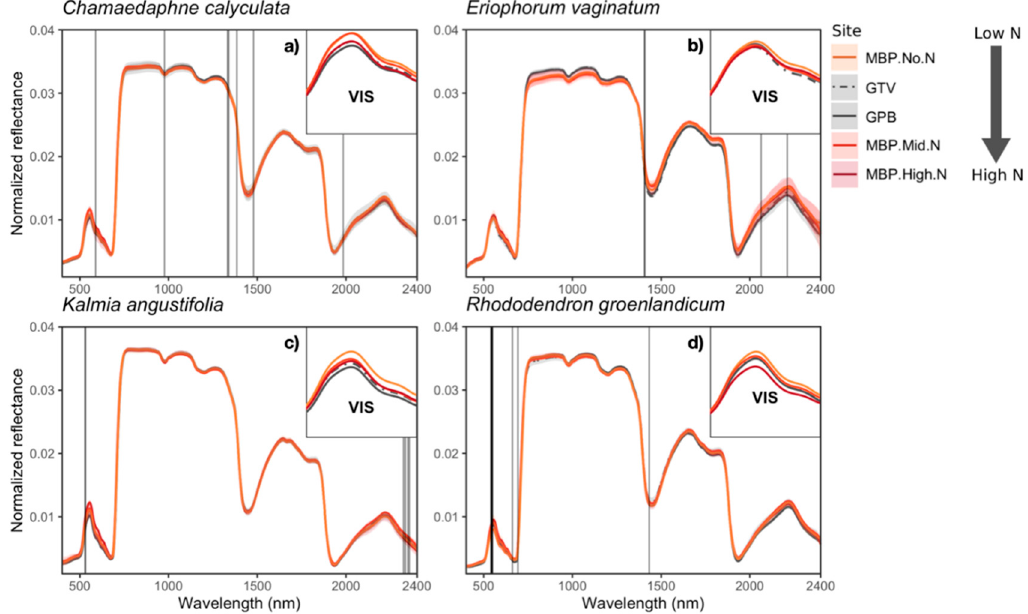
Figure 4. Normalized reflectance foliar spectra (mean ± standard deviation) and visible regions (VIS). Light grey vertical bands indicate the wavelengths contributing most to the separability of populations of species among sites based on the nearest-neighbor criterion in forward feature selection analyses. ( a – d ) Inlets for each species’ spectra, showing the VIS region in more precision.